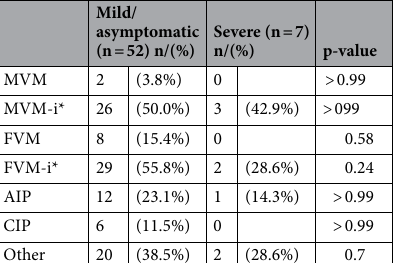
Table 4. Analyses of histopathology of placentas (n = 59). i*Implies that the sample had one or more individual diagnostic features, but criteria for full diagnosis were not met.